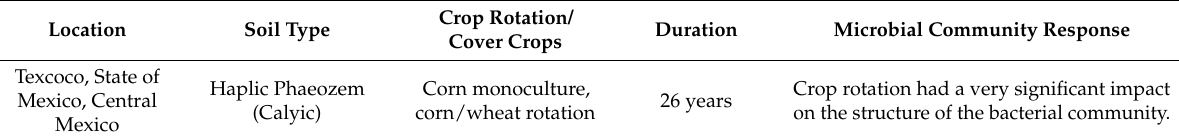
Table 4. Impact of crop rotation/cover crops on the bacterial community of agricultural